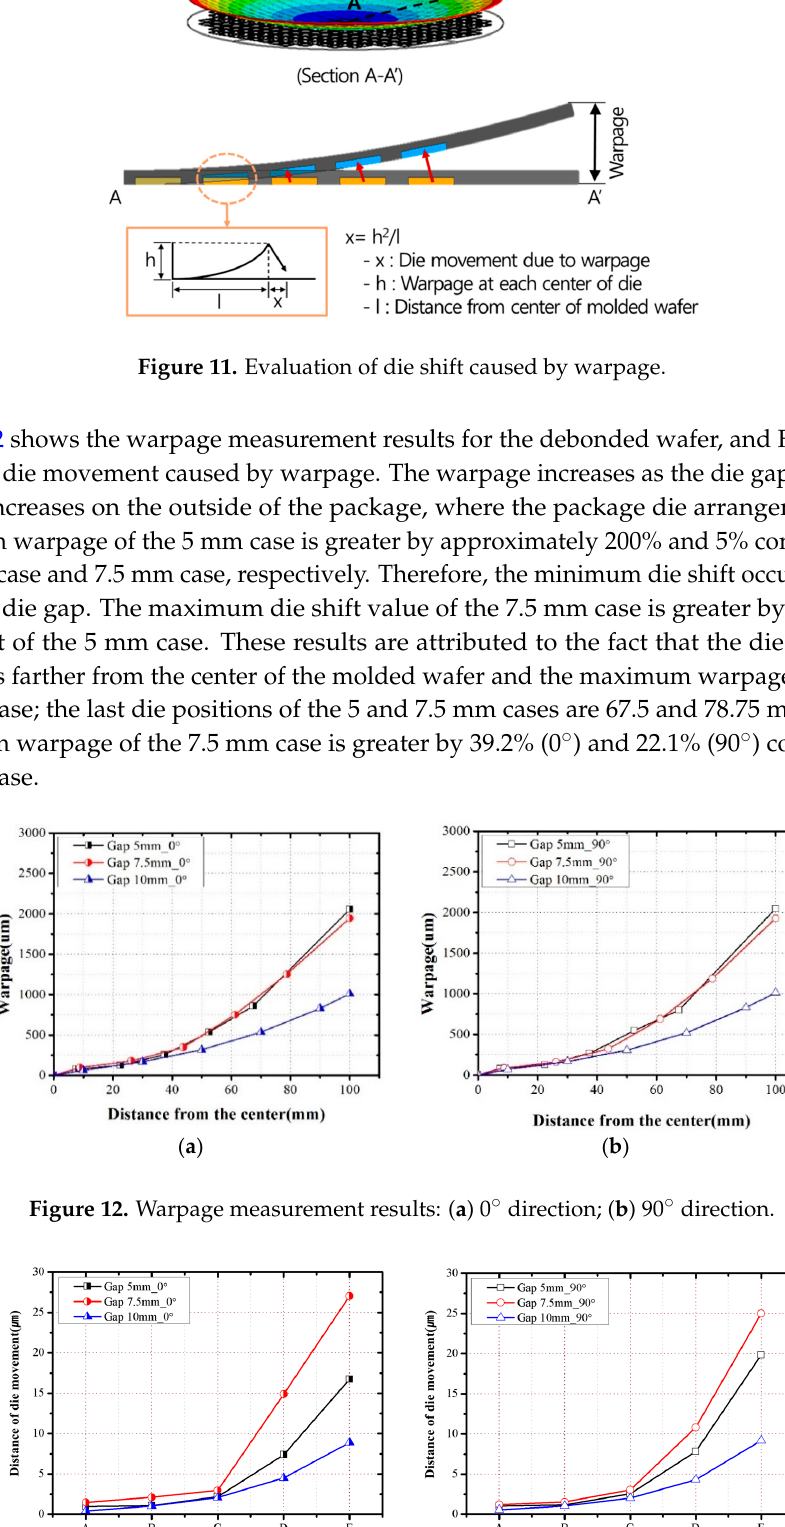
Figure 13. Evaluated die movement caused by warpage: ( a ) 0° direction; ( b ) 90° direction.